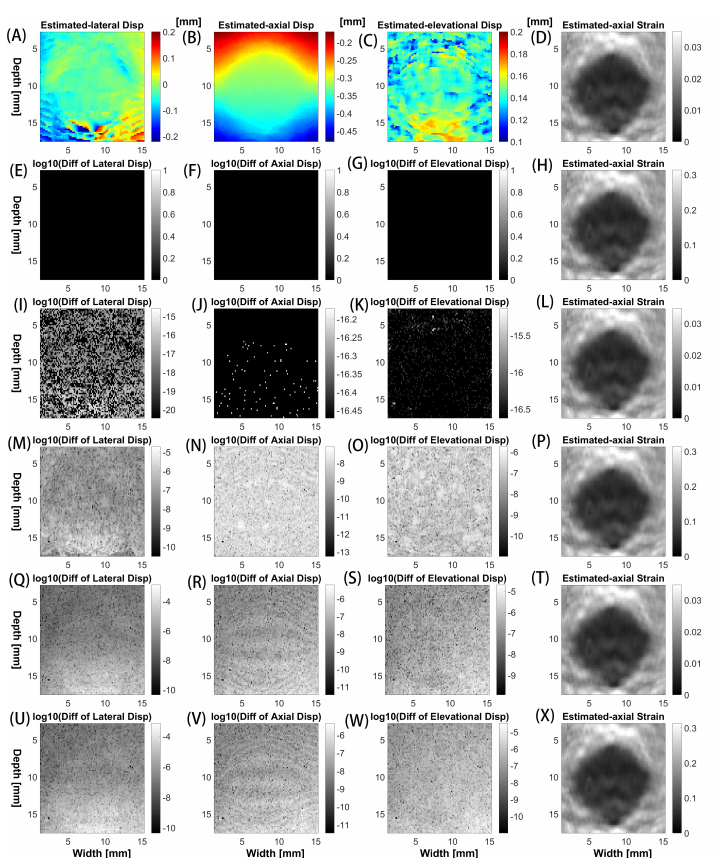
Figure 4. In the first row, ( A ) lateral, ( B ) axial and ( C ) elevational displacements estimated from a TM phantom using the CPU-Version of the standard NCC method. The (displacement) difference images from the first three columns of the second to the sixth rows showing the displacement difference between the stand-NCC-CPU method and one of the other five methods: [second row] Lou-Konofagou-CPU, [third row] Lewis-CPU, [fourth row] NCC-GPU, [fifth row] Lou-Konofagou-GPU and [sixth row] Lewis-GPU. Estimated displacement differences are displayed in a compressed (log fashion except for the results in the second row in which the differences are zeros. Disp. is an abbreviation of displacement. Axial strain images ( D , H , L , P , T , and X ) obtained by six implementations are shown in the fourth column.